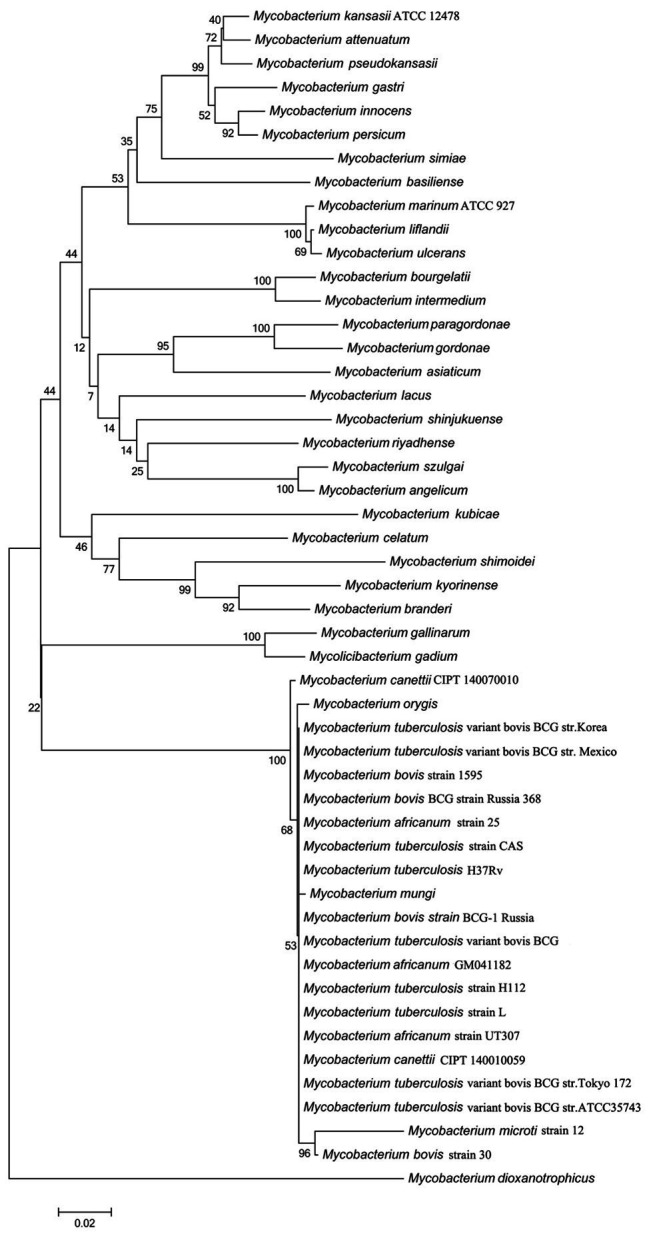
Evolutionary analysis of Rv3091 homologs proteins in mycobacteria using MEGA 7.0 software. Accession numbers for all sequences are provided in Supplementary Table S2.